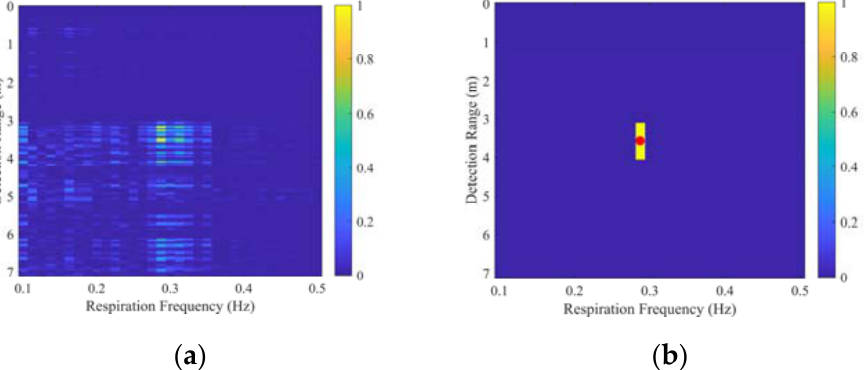
Figure 8. Comparison result processed by the method in [35] of the experiment with a single target: ( a ) range-frequency matrix used for detection; ( b ) result extracted by the 2D CFAR energy windows.